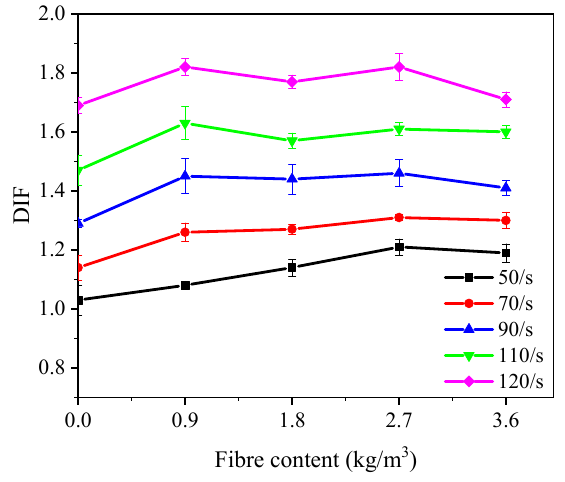
Figure 10. E ff ect of polypropylene fibre content on Figure 10. Effect of polypropylene fibre content on DIF.